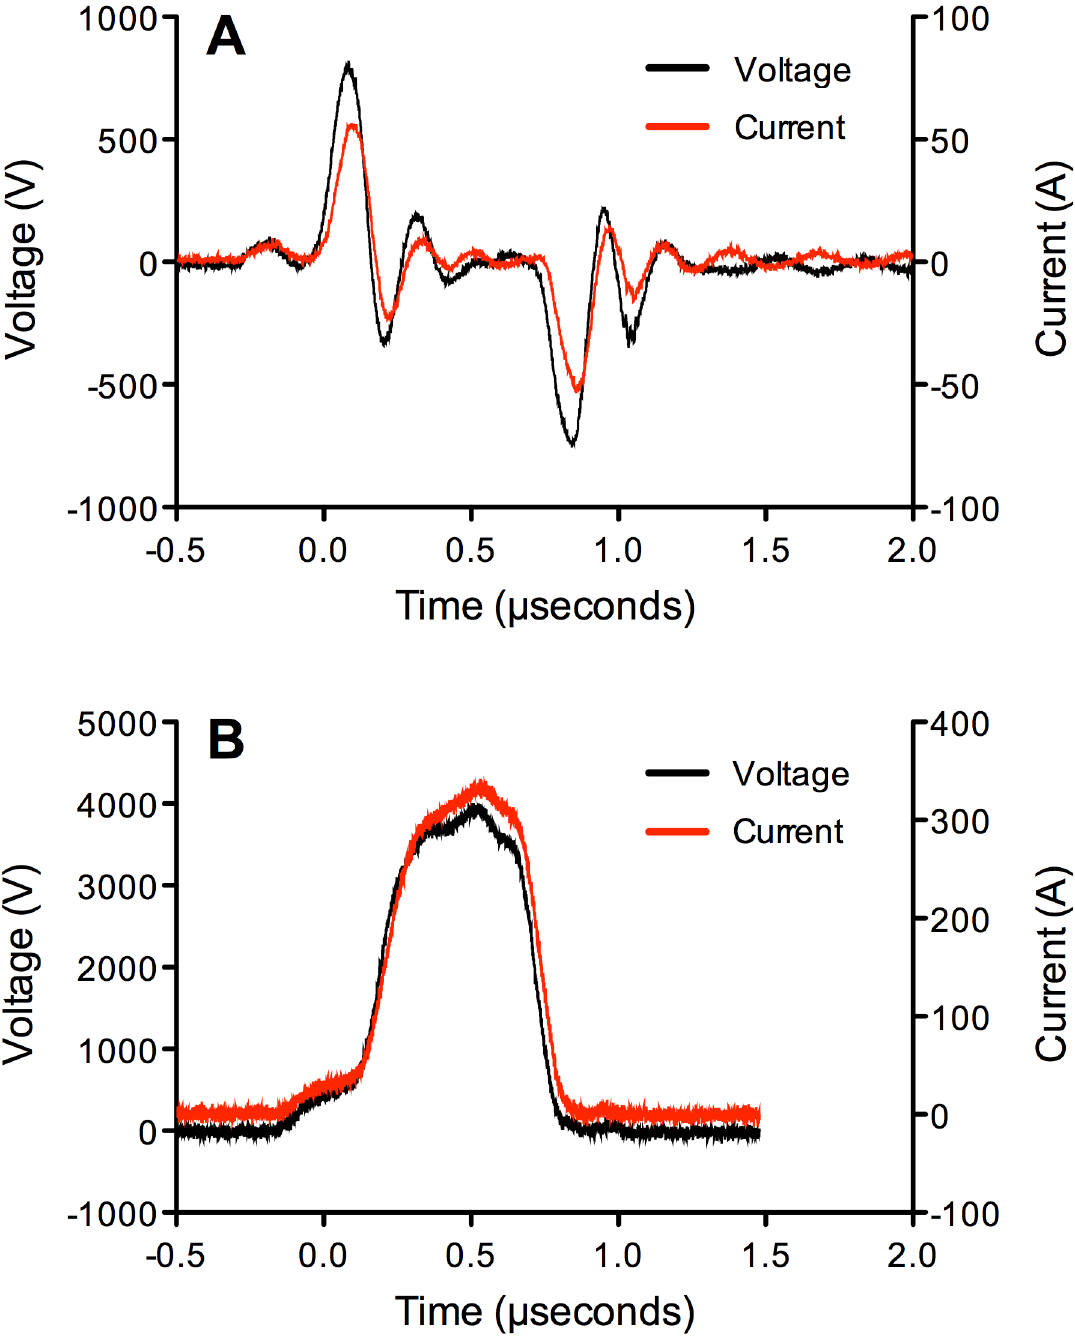
Fig 1. Representative electrical tracings for A) SMLEF bipolar pulse and B) SMHEF monopolar pulse. A) SMLEF bipolar pulse was ~150 ns pulse width, ~650 ns interval between pulses of opposite polarity,~4kV/cm electric field. B) SMHEF monopolar pulse was pulse ~650 ns, 20 kV/cm electric field. Samples received a total of 80 pairs of bipolar SMLEF pulses at 1 second intervals (the spacing between the opposite polarity pulses within a pair of bipolar pulses was about